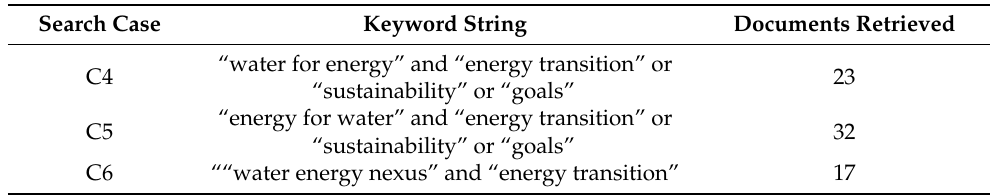
Table 3. Additional searches, keyword strings and documents retrieved in the Scopus database (5 January